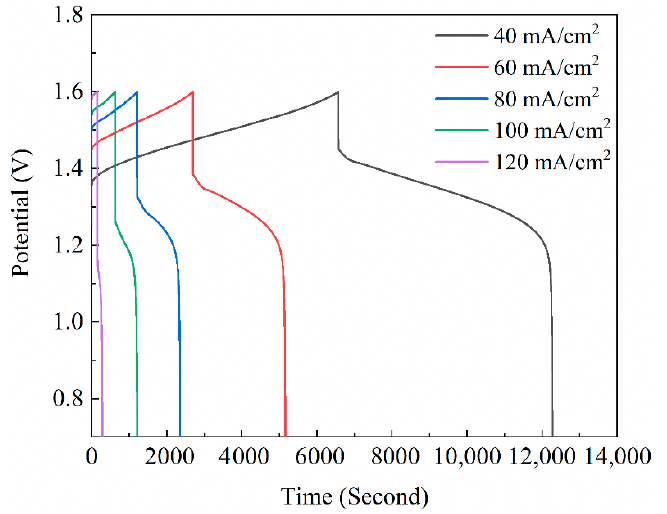
Figure 8. Charge–discharge curves of VRFB single cell using pristine GF and APPJ-coated polydopamine on GF as elec- trodes at a current density of ( a ) 40 mA/cm 2 and ( b ) 80 mA/cm 2 .